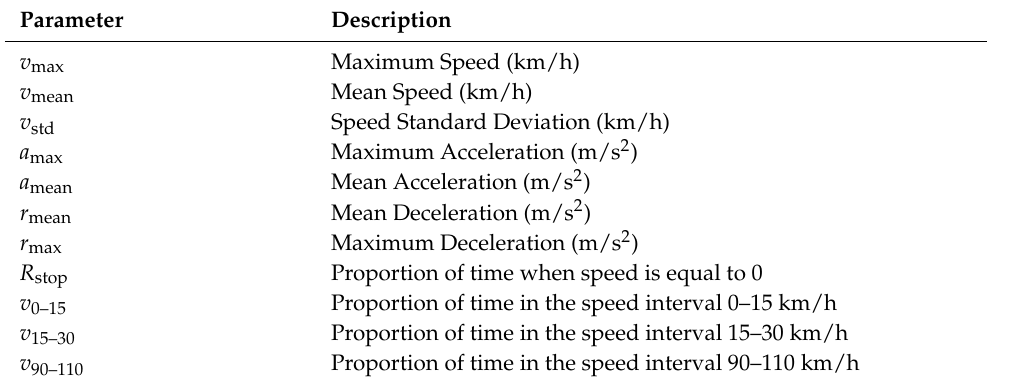
Table 4. 11 Characteristic Parameters.